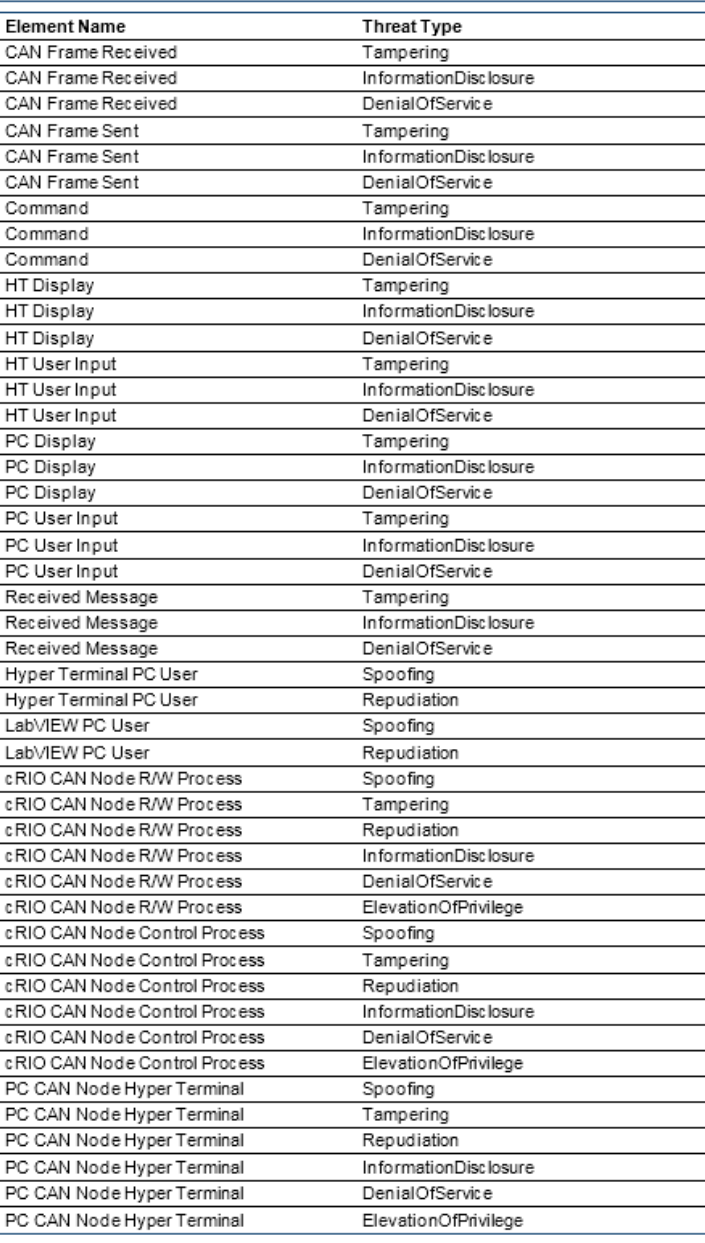
Figure 11. Example of an analysis in the modeling tool.